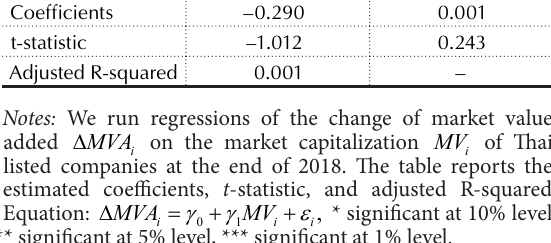
Table 7. The correlation between average MVA’s